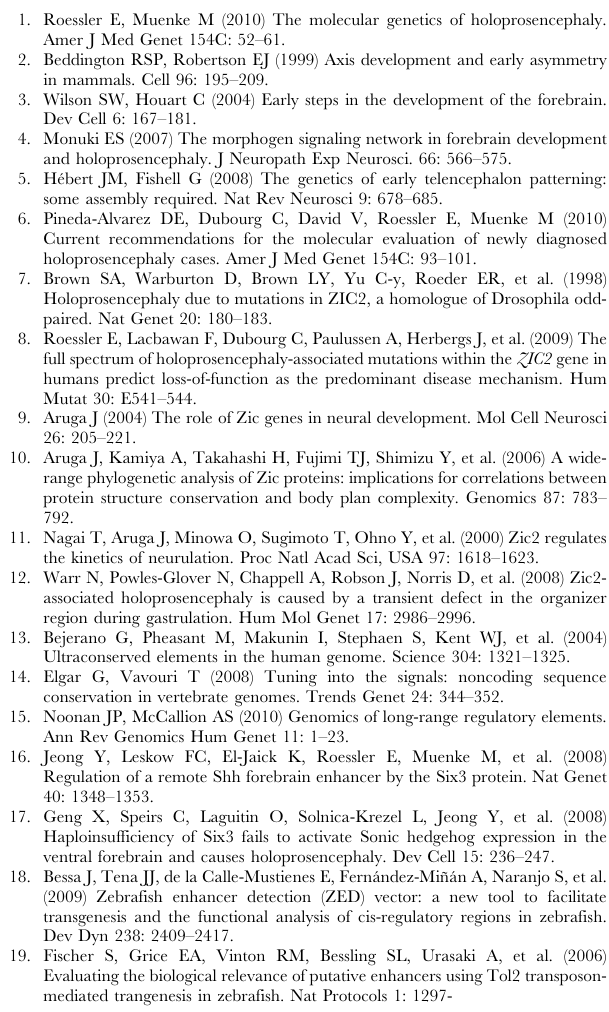
Table S1 Summary of clinical and molecular findings in